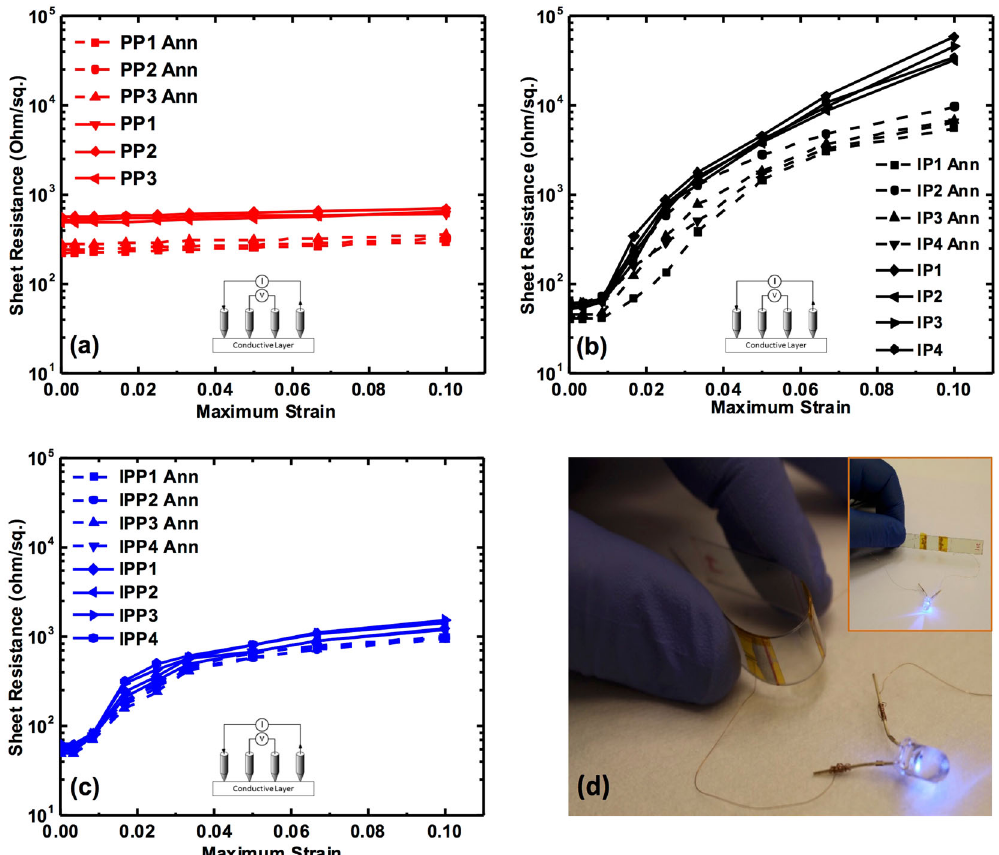
Fig. 5 Applied strain versus four-probe sheet resistance (loading/unloading tensile testing), for the following sets of fi lms: ( a ) PP, ( b ) IP, and ( c ) IPP, respectively, for both as-deposited and annealed samples. d Photograph showing a stretched (~10%) IPP based sample being highly bended performing with a LED, inset shows the LED glow without bending the IPP